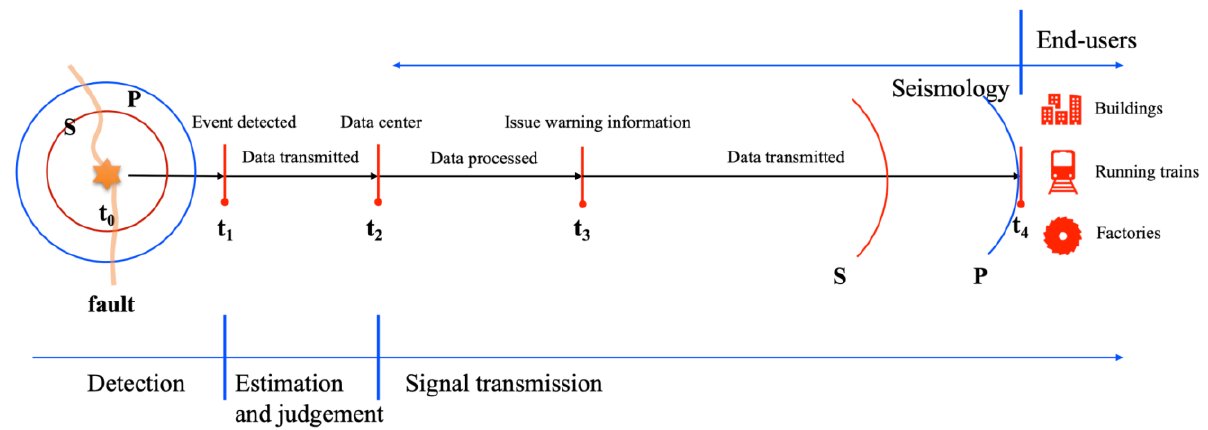
Figure 2. The timeline of an earthquake early warning (EEW) system (adopted from [36,39]).